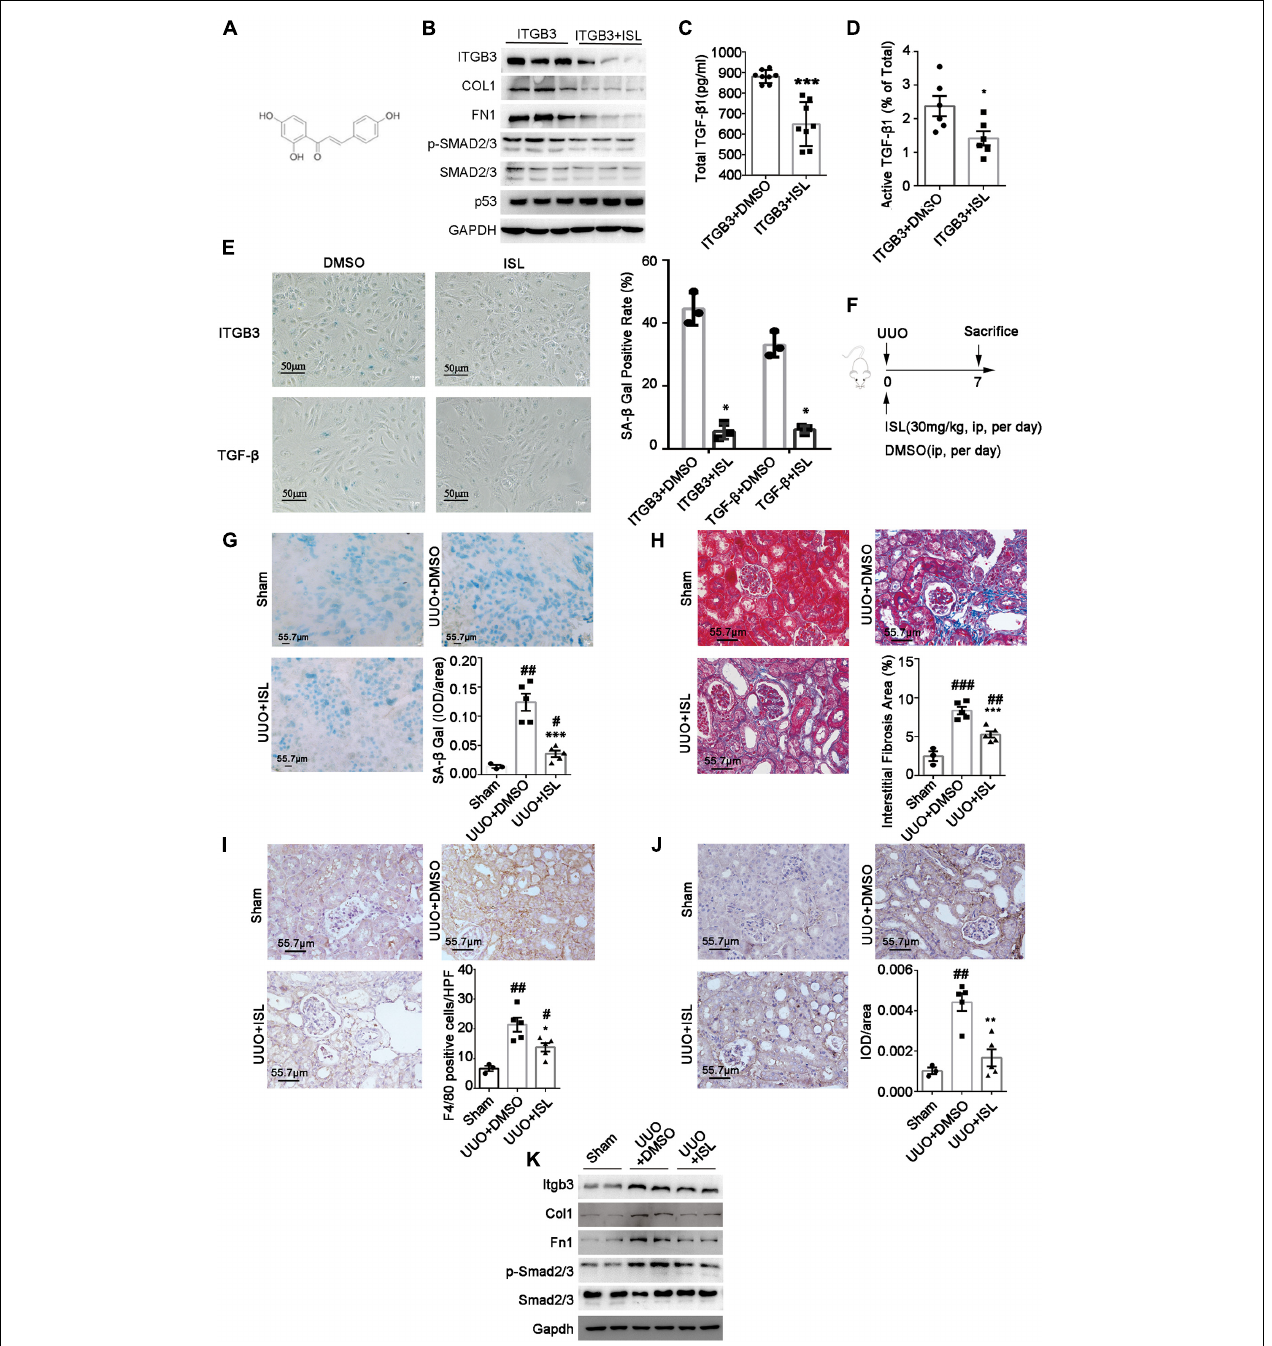
FIGURE 6 | Isoliquiritigenin (ISL) attenuates ITGB3 expression and renal fibrosis in UUO mice. (A) The structure of ISL. (B) Expression of Itgb3, p53, Smad2/3, pSmad2/3, Col, and Fn1 in ITGB3-overexpressed HK-2 cells treated with DMSO or ISL (20 µ M, 24 h). ELISA for (C) total and (D) active TGF- β 1 in culture medium of HK-2 cells transfected with EV or ITGB3 plasmid. (E) SA- β -gal staining of ITGB3-overexpressed HK-2 cells treated with DMSO or ISL (20 µ M) for 24 h (the upper one), or HK-2 cell stimulated with TGF- β (10 ng/ml) for 24 h, then treated with DMSO or ISL (20 µ M) for 24 h (the below one). (F) Schematic diagram of the experimental procedure. (G) SA- β -gal staining in frozen sections of UUO mice treated with DMSO or ISL and Sham mice ( n = 5 for UUO + EV and UUO + ITGB3 group, n = 3 for Sham group). (H) MASSON staining of UUO mice treated with DMSO or ISL ( n = 5 per group). IHC analysis of (I) F4/80 and (J) Fn1 expression in the renal tissues of UUO mice treated with DMSO or ISL and Sham mice ( n = 5 for UUO + EV and UUO + ITGB3 group, n = 3 for Sham group). (K) Western blot analysis of Itgb3, Col, Fn1, Smad2/3, and pSmad2/3 in tubular tissues of UUO mice treated with DMSO or ISL and Sham mice ( n = 5 for UUO + EV and UUO + ITGB3 group, n = 3 for Sham group). For statistical analysis, a two-tailed Student’s t -test was used for panels (C–E,G–J) . * p < 0.05; ** p < 0.01; *** p < 0.001 when compared with the DMSO group; # p < 0.05; ## p < 0.01; ### p < 0.001 when compared with the Sham group. Scale bar = 55.7 µ m, unless otherwise indicated.